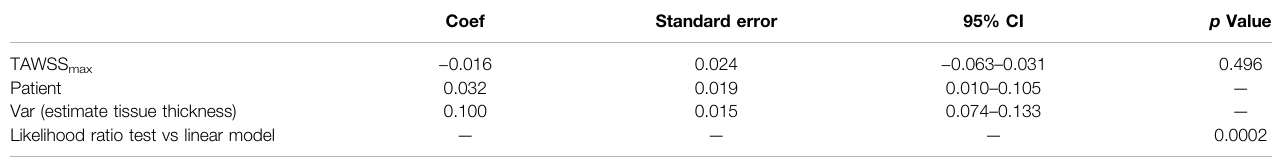
TABLE 5 | Results ofmultilevel mixed-effects linear model for the main outcome of tissue thickness. The fi xed effects part ofthe model tested the in fl uence of TAWSS max on thickness, whilst the random effect part of the model tested the in fl uence of the patient. From these results, the in fl uence of WSS alone on thickness does not occur in isolation and the variance occurring at the patient level is an important in fl uencing factor.